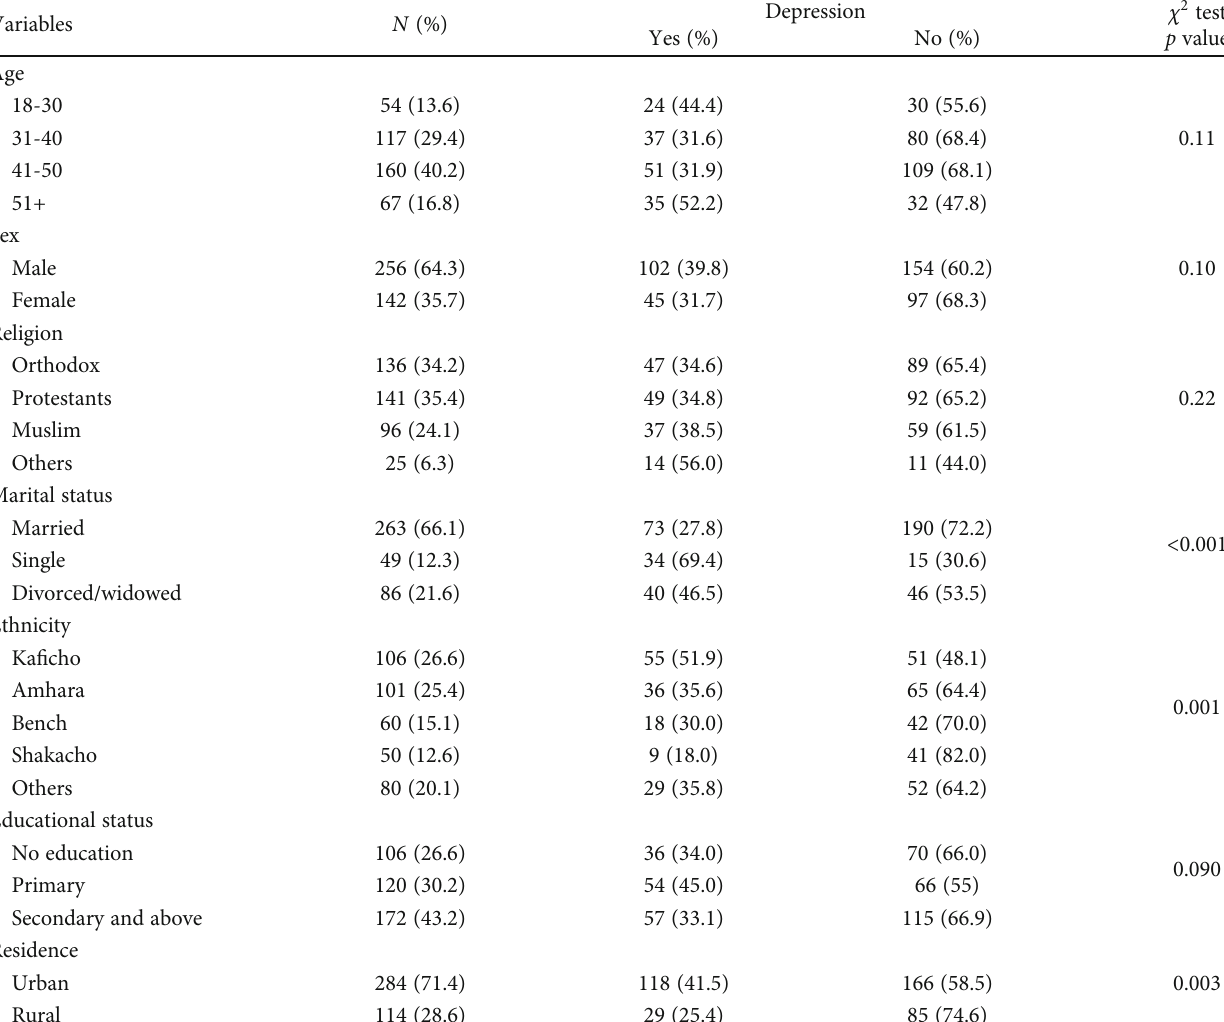
Table 1: Sociodemographic characteristics of DM patients on follow-up in MTUTH and TGH, Southwest Ethiopia, July 2018 ( n = 398 ).